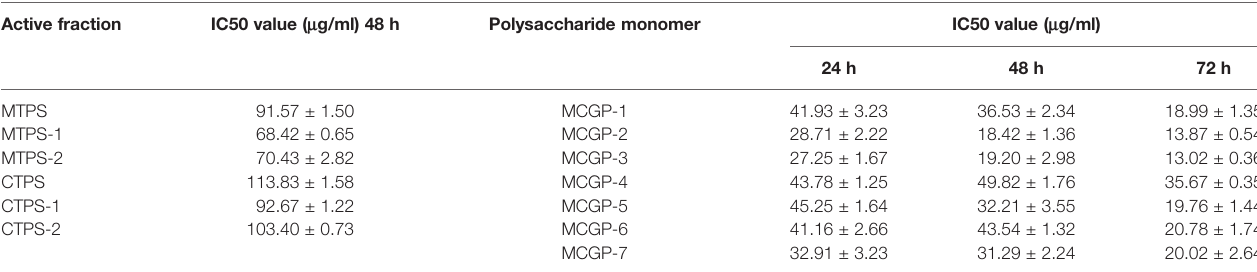
TABLE 3 | IC 50 value of ginseng polysaccharide in vitro